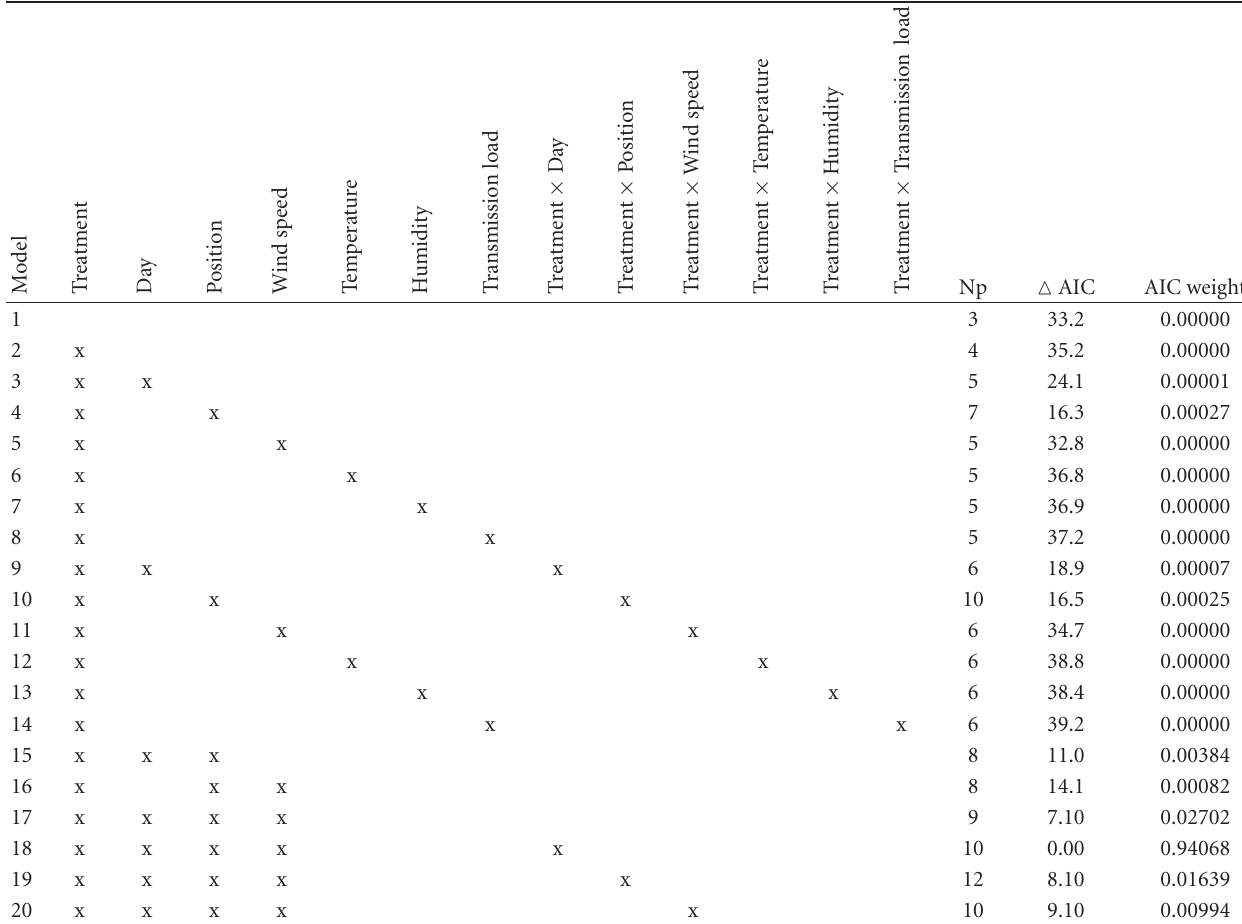
Table 6: Results from model selection on restless behaviour among domestic wild animals using the AIC criterion (Np is number of